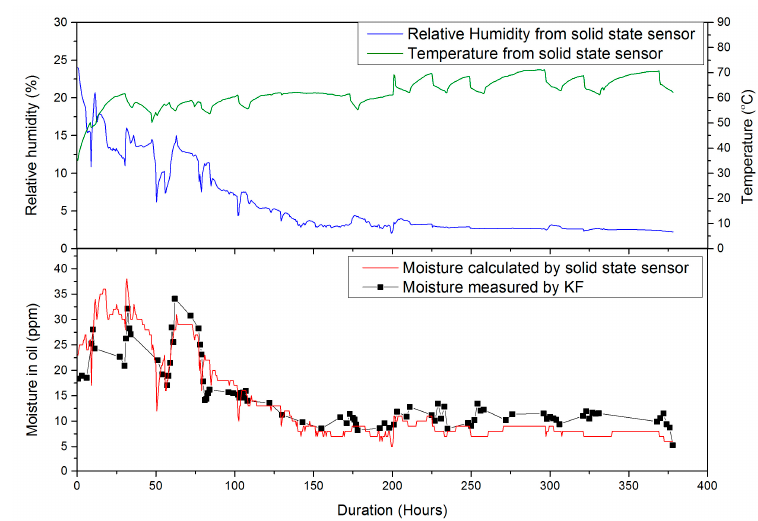
Figure 7. Comparison of moisture in oil measured by KF titration and moisture in oil calculated by solid state sensor, along with oil relative humidity and temperature.